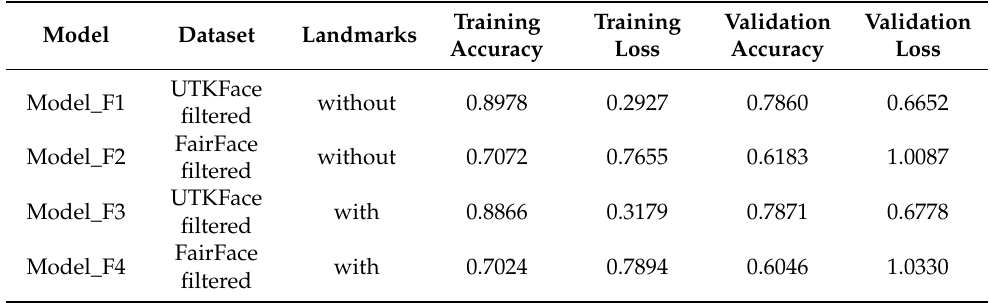
Table 7. Comparison of training and validation results on UTKFace filtered and FairFace filtered